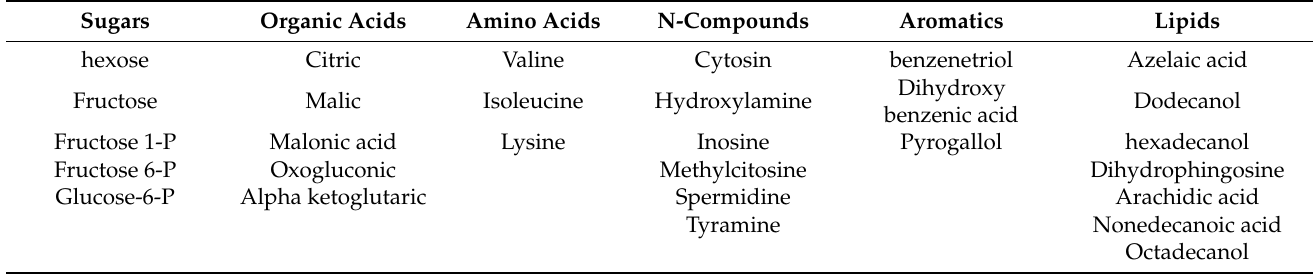
Figure 7. The concentration map of aromatic compounds (heat map of scaled concentrations) by plants treated with humic acids (HA) or not (Control). Table 1. Cell metabolic compounds identified by GC-TOF/MS were found in significantly larger concentrations by F test ( p < 0.001) in leaf tissues of rice seedlings treated with humic acids isolated from